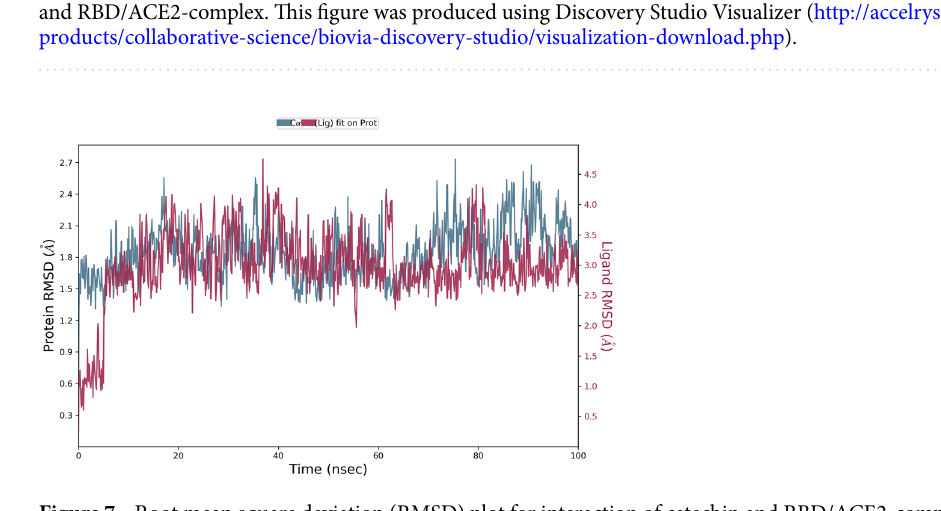
Figure 7. Root mean square deviation (RMSD) plot for interaction of catechin and RBD/ACE2-complex during 0–100 ns of molecular dynamic